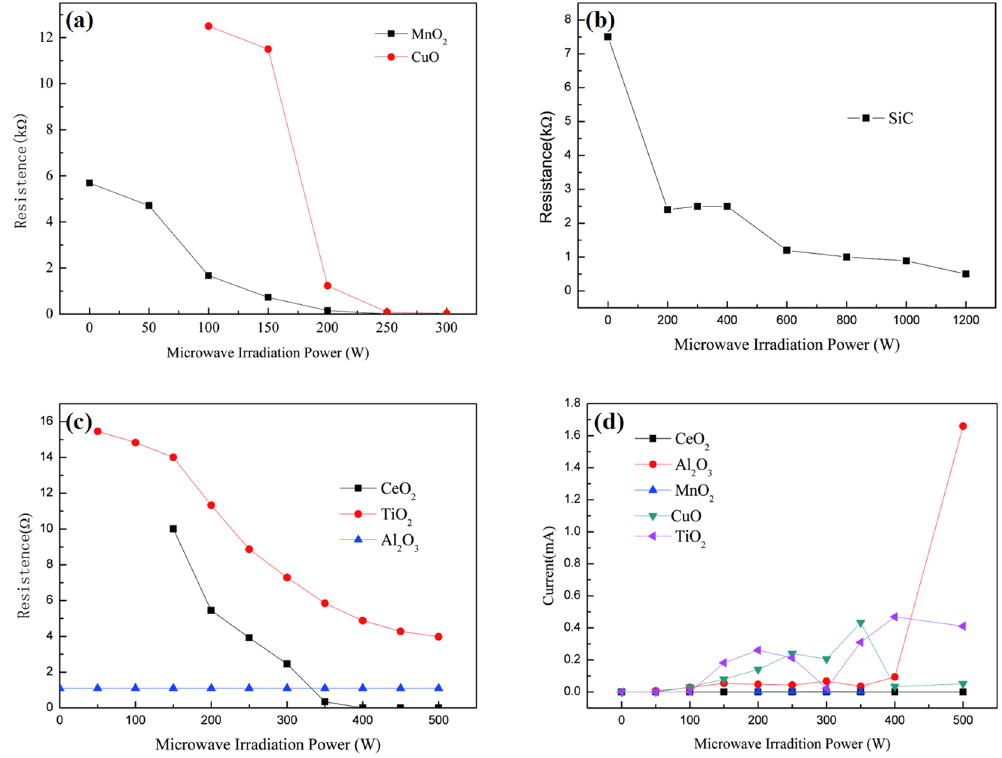
Figure 1. The change of conductivity with MW irradiation input power (P MW )( a – c ) and the effect of P MW on produced electric current ( d ).